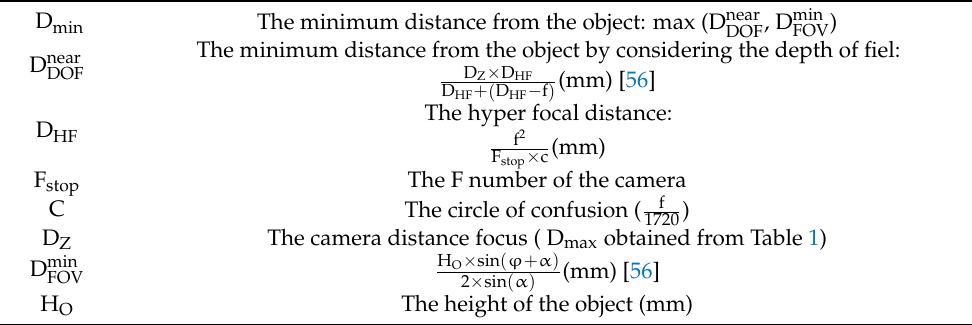
Table 2. The equations for obtaining the minimum distance from the